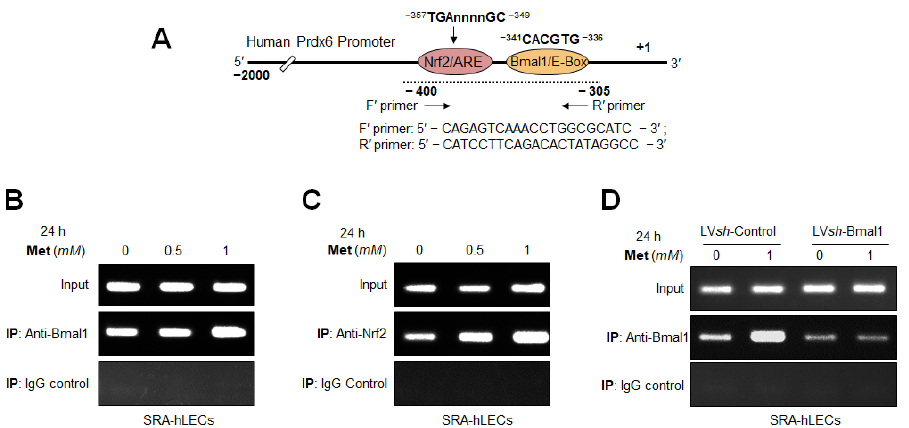
Figure 13. In vivo DNA binding assay revealed enhanced enrichment of Bmal1 to its binding at E-Box and Nrf2 to its ARE sites of Prdx6 promoter in Metformin-treated SRA-hLECs. Diagrammatic sketch of the 5 ′ -constructs of Prdx6 promoter containing Bmal1/E-Box- and Nrf2/ARE-DNA binding sites and ChIP primers sequences used for ChIP assay shown in Figure 12A. ( B , C ) DNA binding experiments with SRA-hLECs treated with Metformin was performed as noted in Figure 12. Increased binding of Bmal1 and Nrf2 to its responsive elements in the Prdx6 promoter was observed, suggesting SRA-hLECs responded similarly with Metformin as primary hLECs, suggesting SRA-hLECs are a good alternative for primary hLECs to elucidate the mechanism(s) of protective activity of therapeutic molecules. Chromatin samples were prepared from SRA-hLECs treated with different concentrations of Metformin and were submitted to ChIP assay with ChIP grade antibodies anti-Bmal1 ( B ) and anti-Nrf2 ( C ) and anti-IgG ( B , C ). Immunoprecipitated DNA fragments were purified and processed for PCR analysis using primers that specifically recognize fragments of Bmal1 and Nrf2 binding site (−400 to −305) of human Prdx6 gene promoter as indicated. Immunoprecipitated/pulled DNA fragments were subjected to RT-PCR analysis. Fragmented DNA was amplified with primers that specifically recognized a fragment of human Prdx6 promoter containing E-Box or ARE site. 10% sheared chromatin was used as input. Control IgG was used as negative control. ( D ) Bmal1 knockdown SRA-hLECs involvement of Metformin to enhance the Bmal1 binding to E-Box in the Prdx6 promoter in vivo. SRA-hLECs were stably infected either with GFP (green fluorescence protein) linked lentiviral (LV) Sh -control or GFP-linked LV Sh Bmal1 as described materials and Methods section. Genomic DNA isolated from LV Sh control and LV Sh Bmal1 SRA-hLECs were cross-linked to immobilize bound protein in vivo, was sheared and immunoprecipitated with anti-Bmal1 or control IgG. Immunoprecipitated DNA was amplified using PCR with specific primers. 10% chromatin was used as input DNA. Amplified DNA band visualized with ethidium bromide staining as shown in photographic